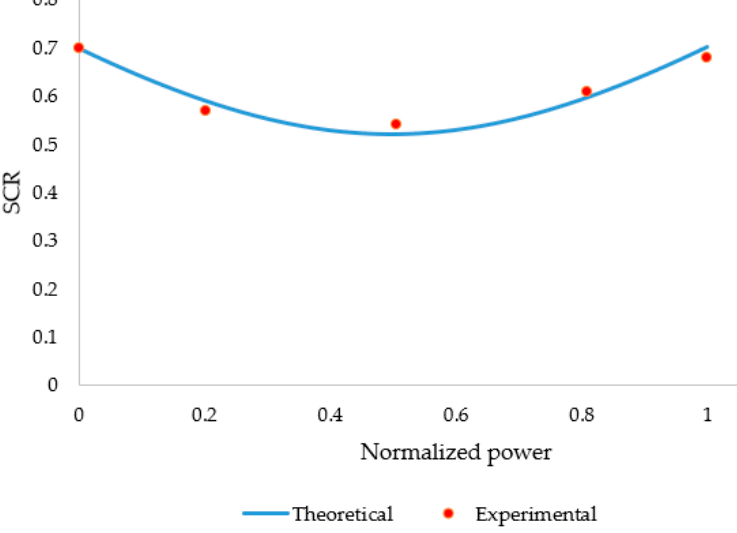
Figure 10 . The speckle contrast ratio (SCR) as a function of normalized power (P λ 2 /(P λ 1 +P λ 2